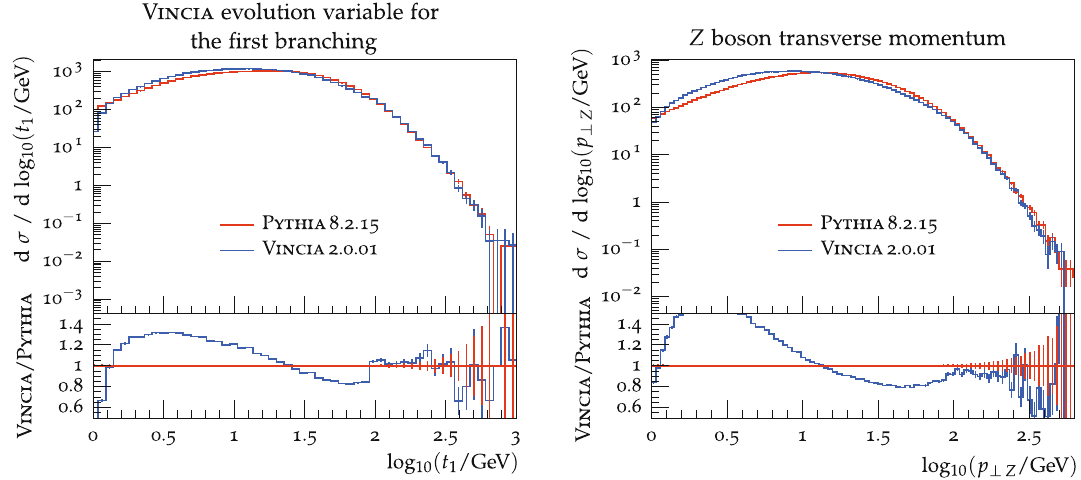
Fig. 5 Distribution of the Vincia evolution variable after the first branching ( left ) and the Z boson transverse momentum ( right ) for pp → Z + jets at parton